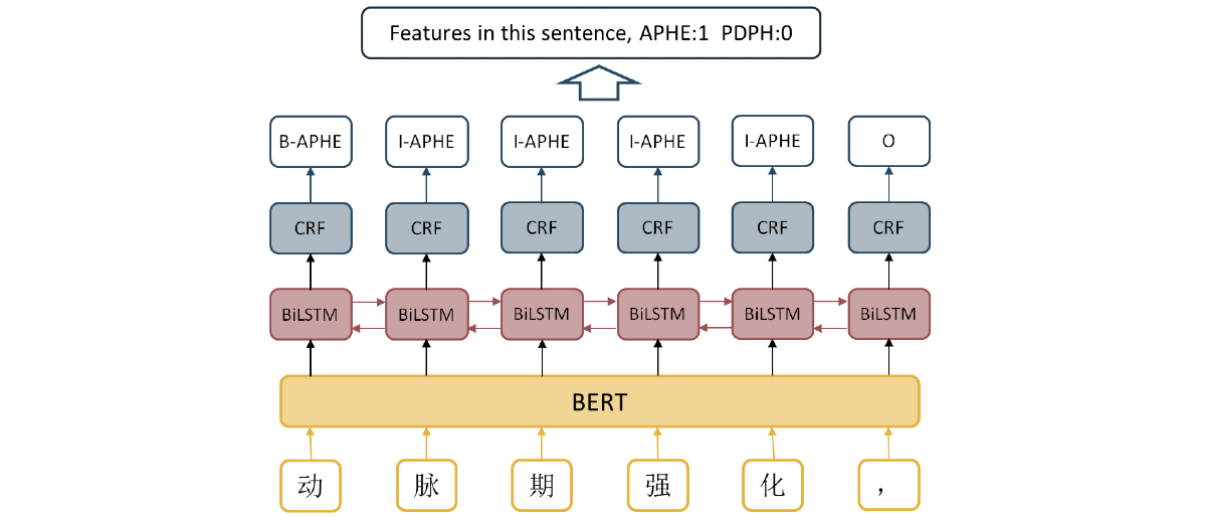
Detailed descriptionsExpressions of APHE and PDPH in Chinese